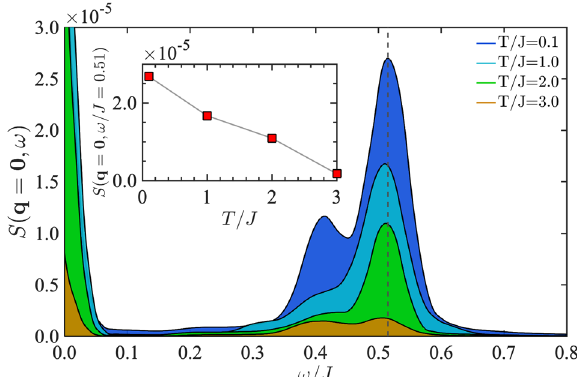
Fig. 4 Spin-wave mode at zero wave vector across the paramagnet- skyrmion crystal transition. The energy dependence of the dynamical spin structure factor S ( q = 0 , ω ) at different temperatures across the phase transition to the skyrmion crystal is shown. The linear decay (inset) of the S ( q = 0 , ω ) amplitude at energy ω / J = 0.51 suggests the absence of a sharp transition.